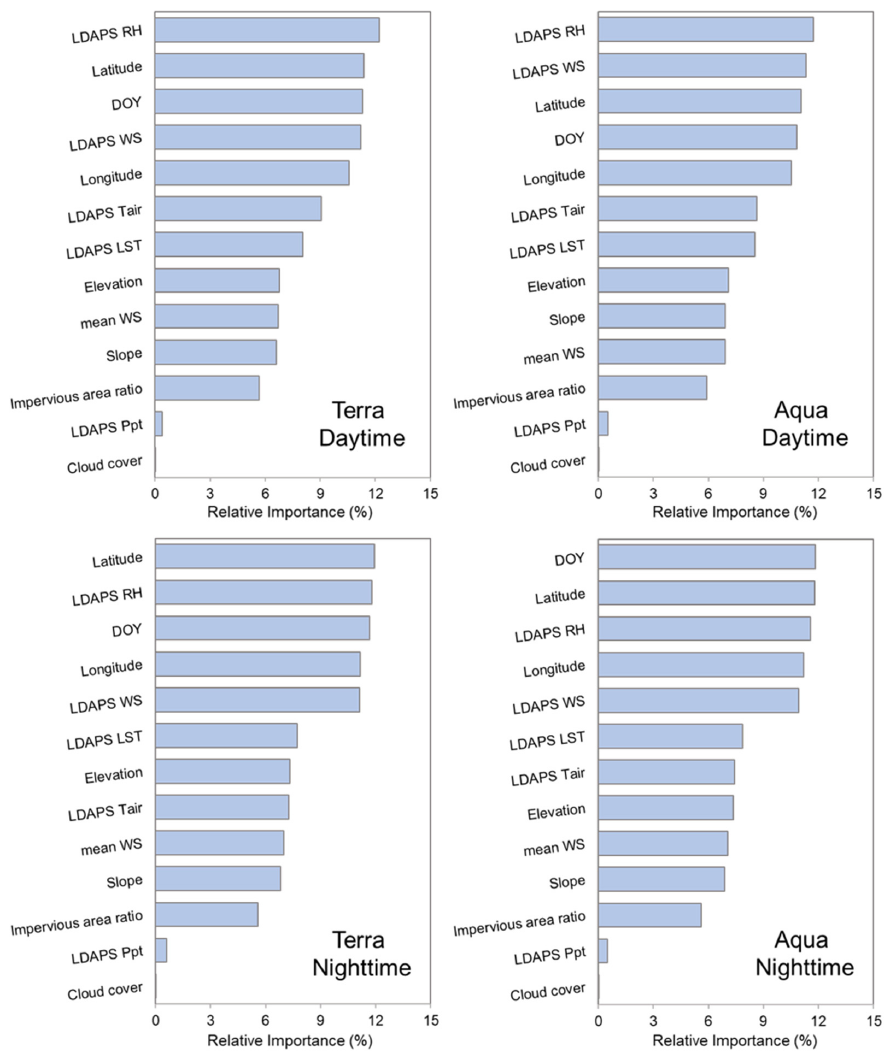
Figure 10. Relative variable importance calculated from the LightGBM model for four MODIS view times. Relative variable importance was normalized by sum to 100%. Table 3. LOSOCV results of the proposed LightGBM and two scenario models (i.e., scenario 1 and scenario 2) for clear and cloudy-sky